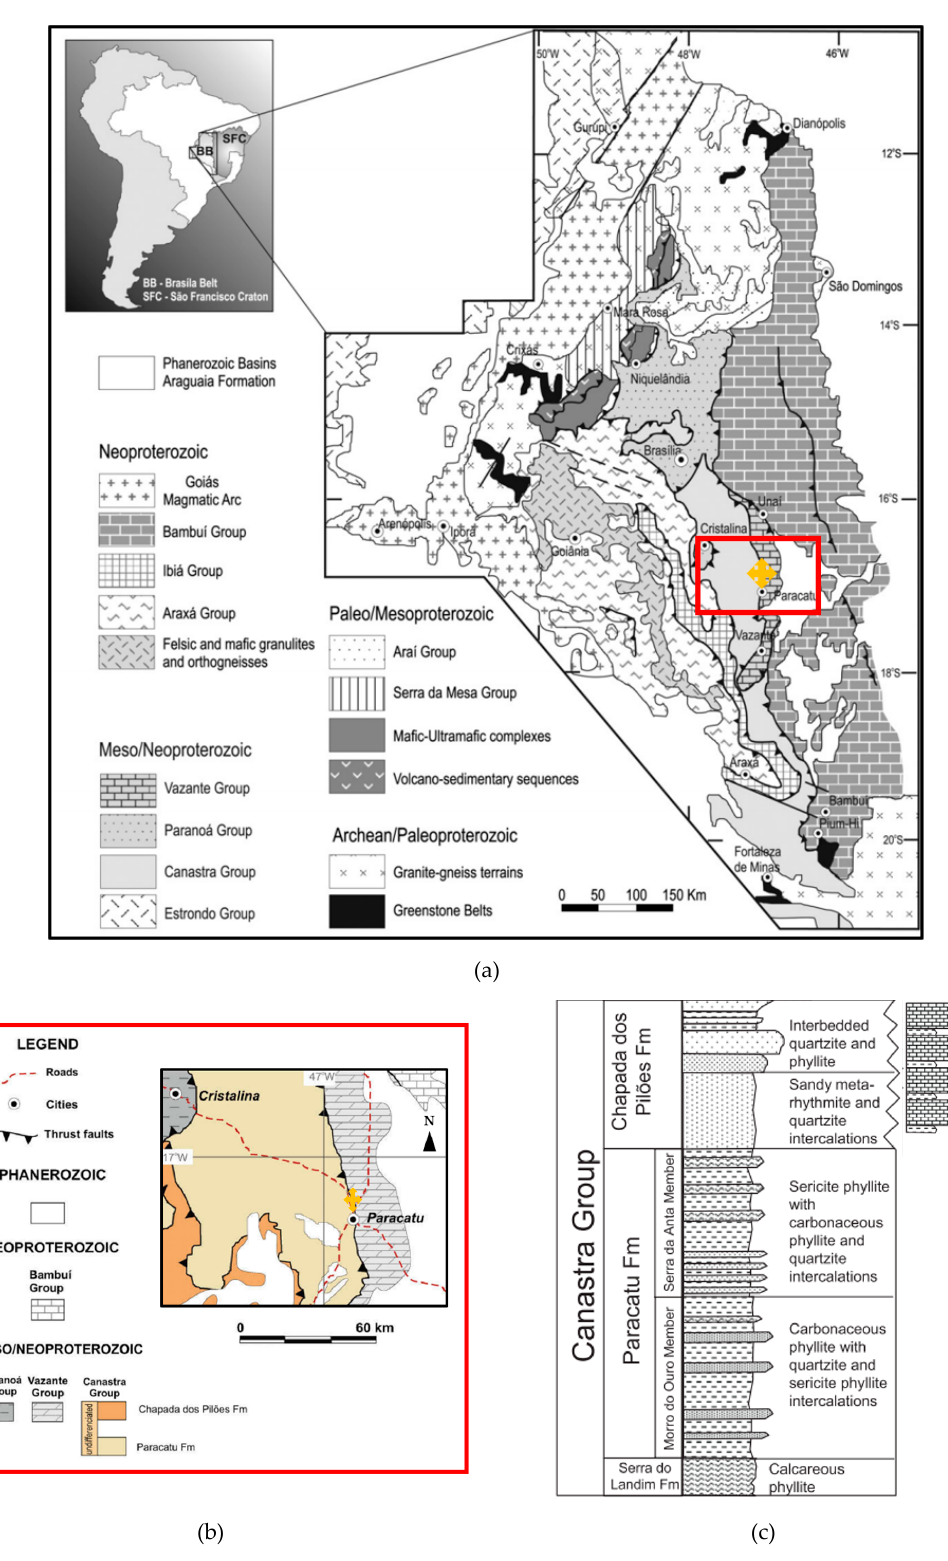
Figure 1. Geological setting of the Paracatu deposit. Yellow marker in ( a ) and ( b ) locate the mine site. ( a ) Geological map depicting the Central Domain units and E-verging continental fold-thrust system of the continental Brasilia Fold Belt (modified from [25], after [24]). ( b ) Area in red inset from ( a ) showing the regional geology and thrust fault at Paracatu (modified from [27]). ( c ) Inferred, not to scale, stratigraphic column of the Canastra Group [27].